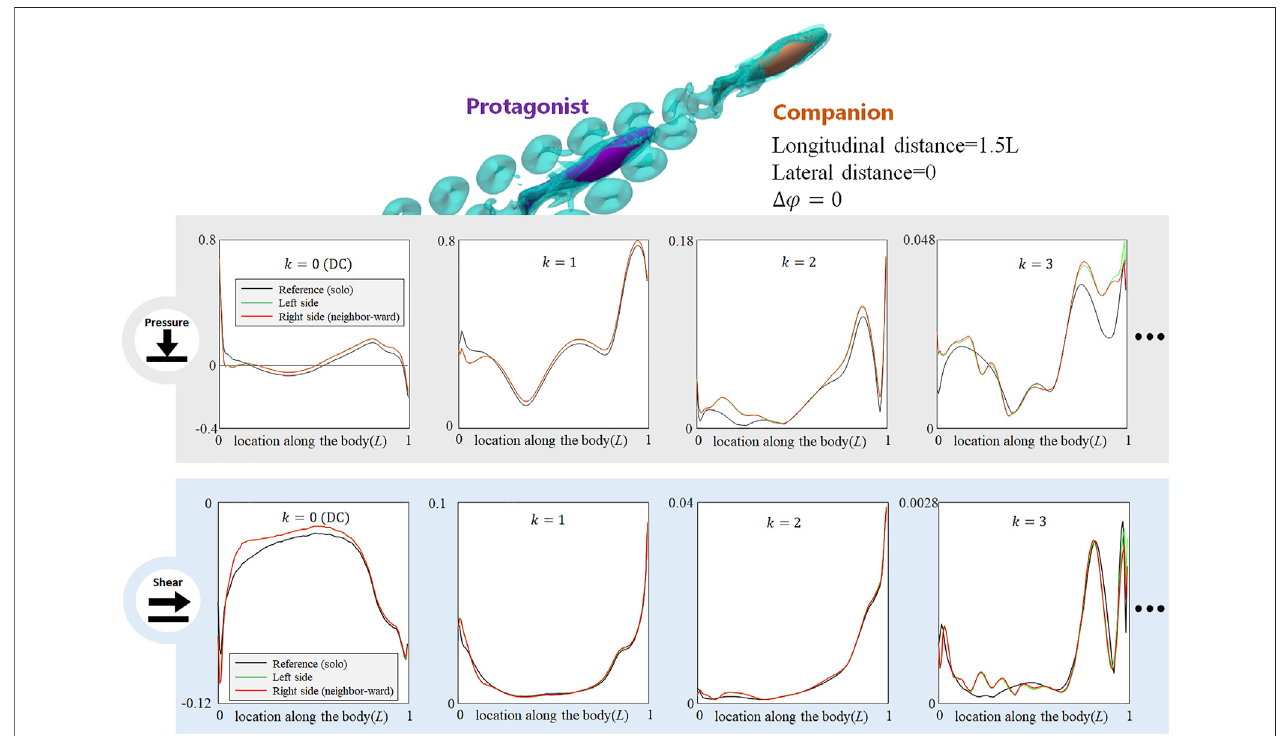
FIGURE 7 | Signal features sensed by the protagonist fi sh when an in-phase neighbor is in front. Full results are presented in Supplementary Figure S10 , ESM. One stress unit = 10 Pa.